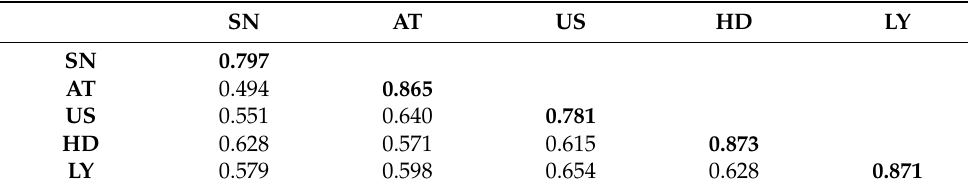
Table 5. Discriminant validity [114].